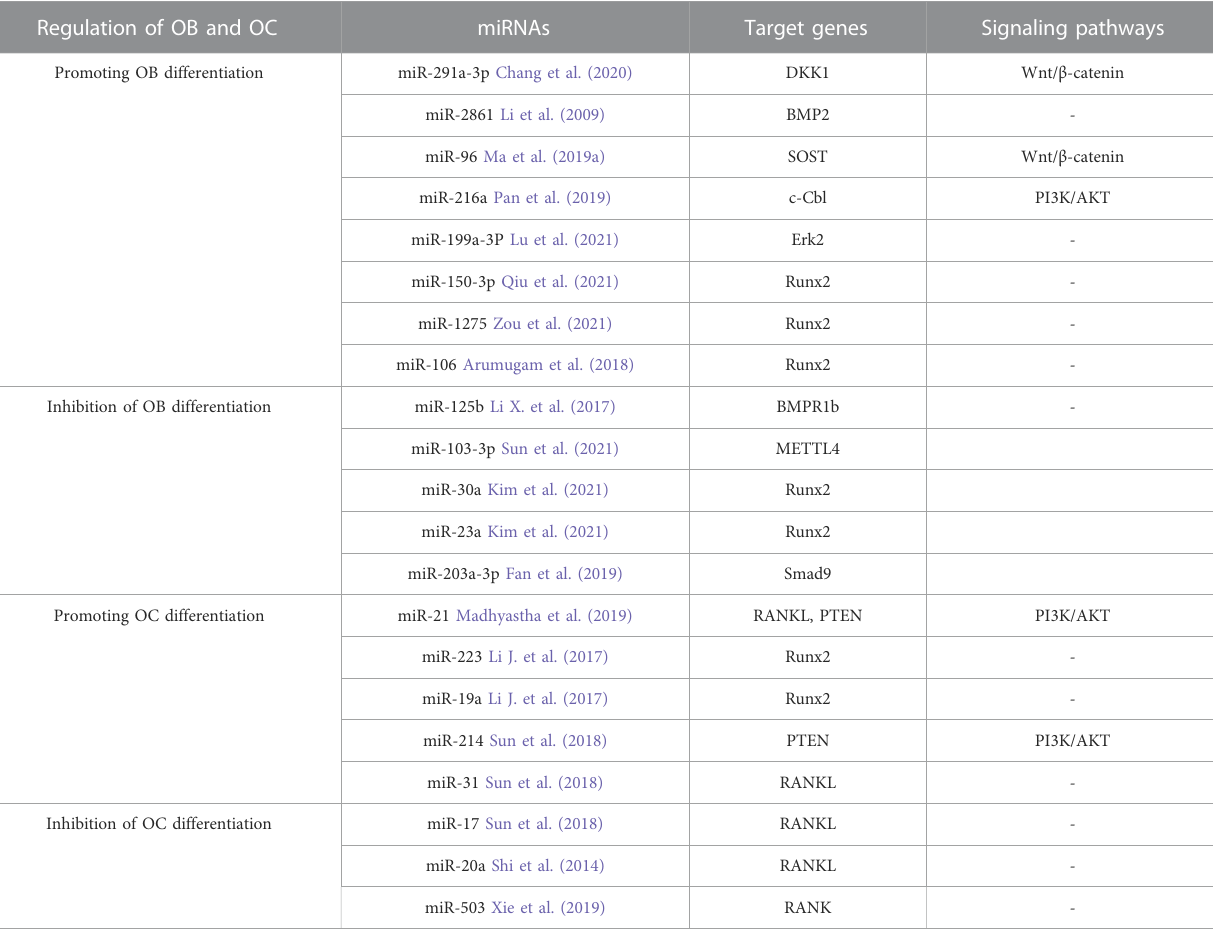
TABLE 3 miRNAs play a role in controlling the biochemical processes of bone development. Regulation of OB and OC